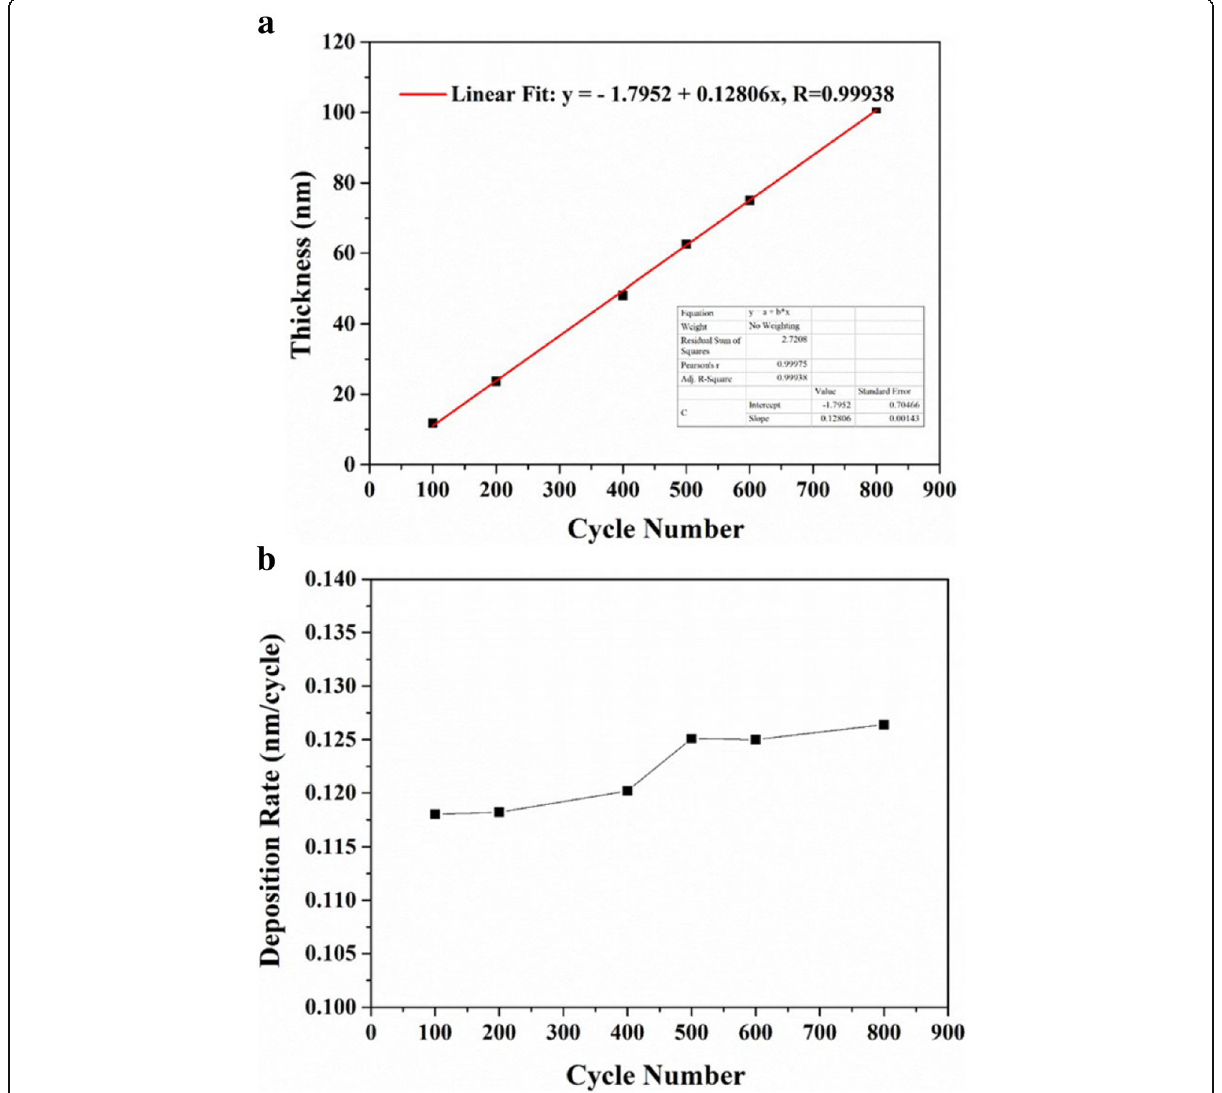
Fig. 2 The changes of thickness ( a ) and deposition rate ( b ) for ZrO 2 thin films as a function of the number of deposition cycles. The deposition temperature is 250